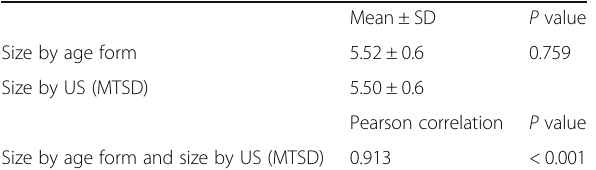
Table 2 ETT size by age vs ETT size by US (MTSD) Table 3 Nearest ETT size by age vs nearest ETT size by US